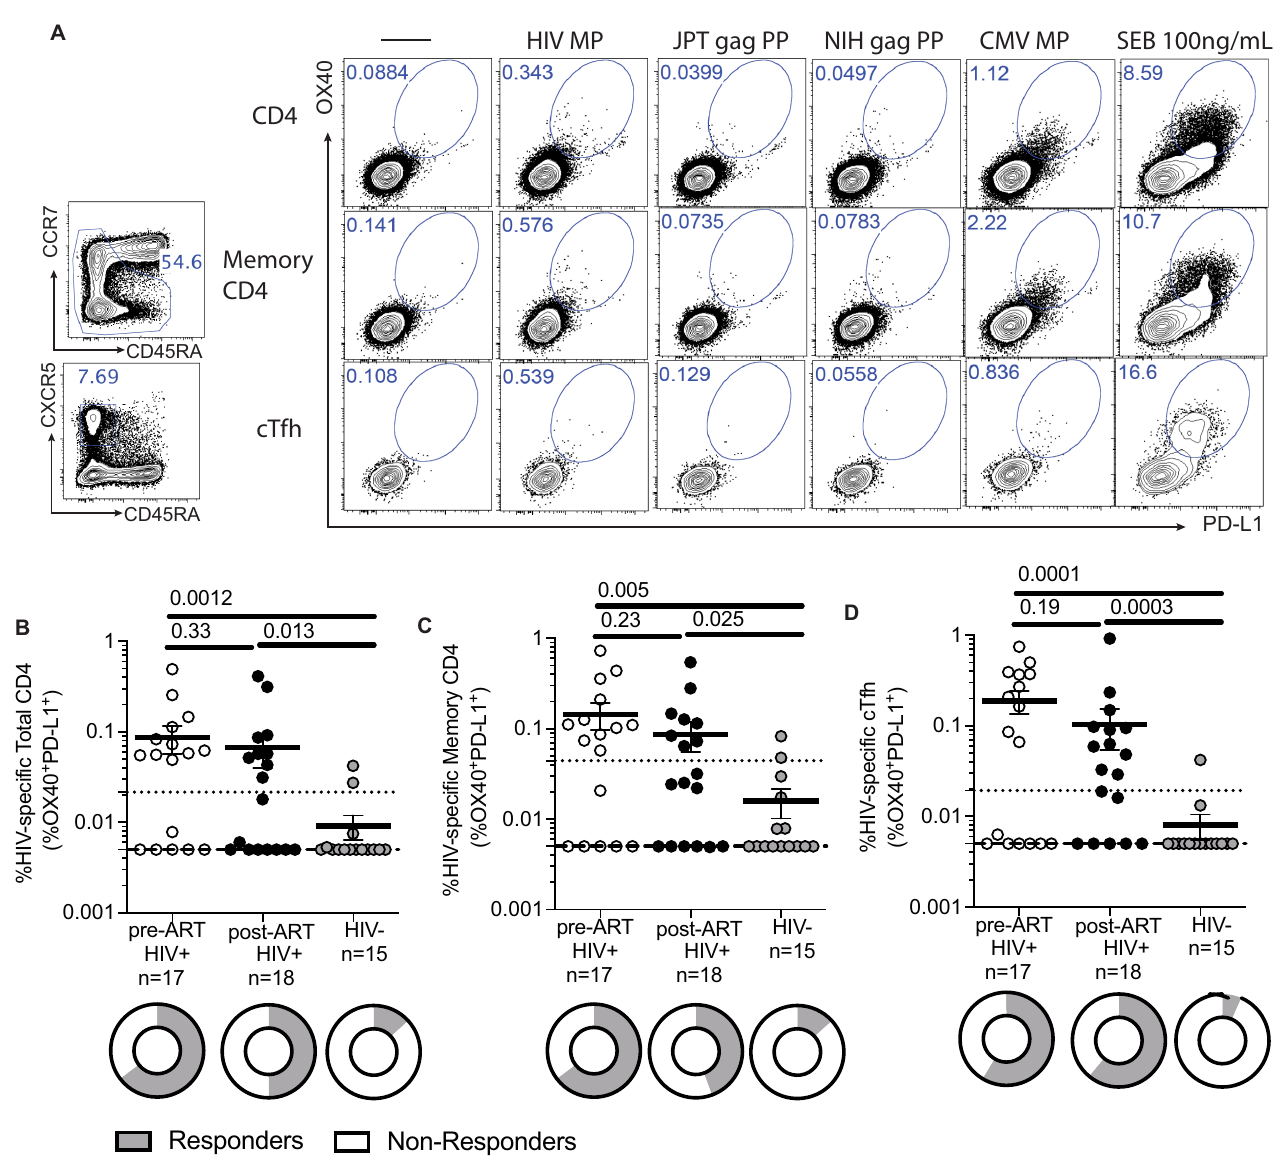
Fig 1. Detection of HIV-specific CD4 + T cells. (A) Sample flow cytometry plot showing gating strategy for HIV-specific CD4 + T cells based on co-expression of OX40 and PD-L1 on total CD4, memory CD4, and cTfh cells. Specimens from HIV infected donors have a higher frequency of (B) HIV-specific total CD4 + T cells (C) HIV-specific memory CD4 + T cells, and (D) HIV-specific cTfh cells compared to HIV uninfected specimens. There was no statistical difference between the mean frequencies pre-ART and post-ART specimens. Data was background subtracted. P-values by Mann-U Whitney test. Limit of detection (dashed line) was set at 0.005%. Limit of sensitivity (dotted line) was 0.022% for HIV-specific total CD4 + T cells, 0.044% for HIV-specific memory CD4 + T cells, and 0.019% for HIV-specific cTfh cells. Data presented represents mean ± standard error of the mean. Pie charts depict proportion of